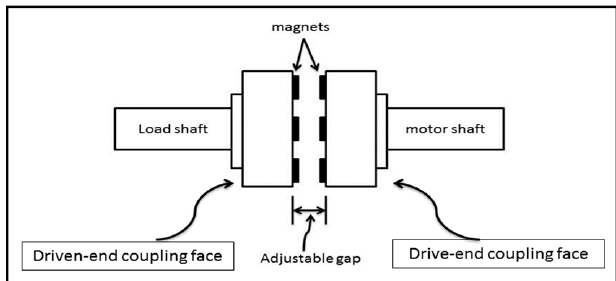
Figure 1. Schematic of the PMC mechanism.